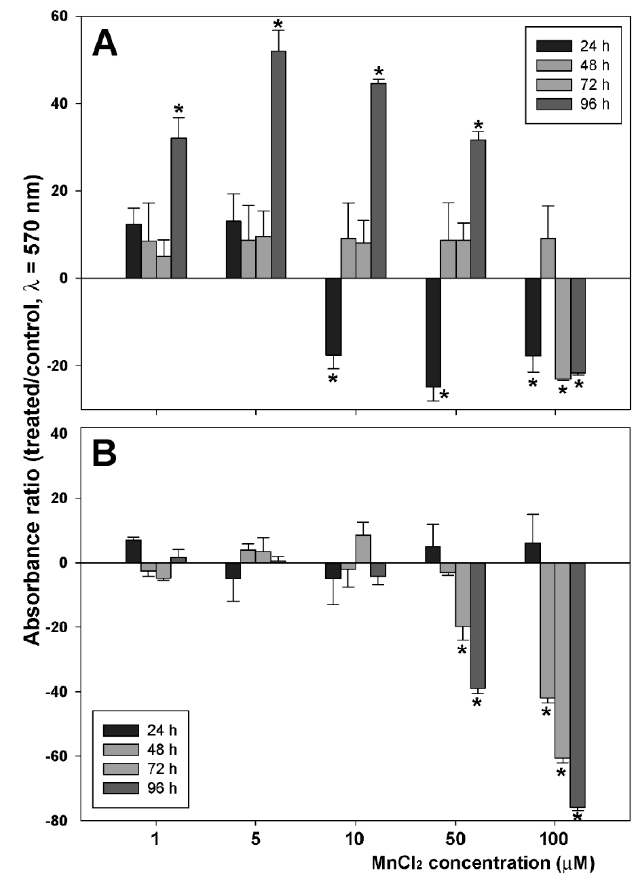
Figure 1. Effect of exposure of MDA-MB231 ( A ) and HB2 ( B ) cells to different concentrations of MnCl 2 for 24, 48, 72, and 96 h. The histogram shows the percent ratio between the crystal violet absorbance of exposed cells and that of untreated controls. Four replicates were run for each assay. The results are expressed as the mean ± standard error of the mean (SEM) from quadruplicate assays. Four replicates were run for each assay. * p < 0.05.